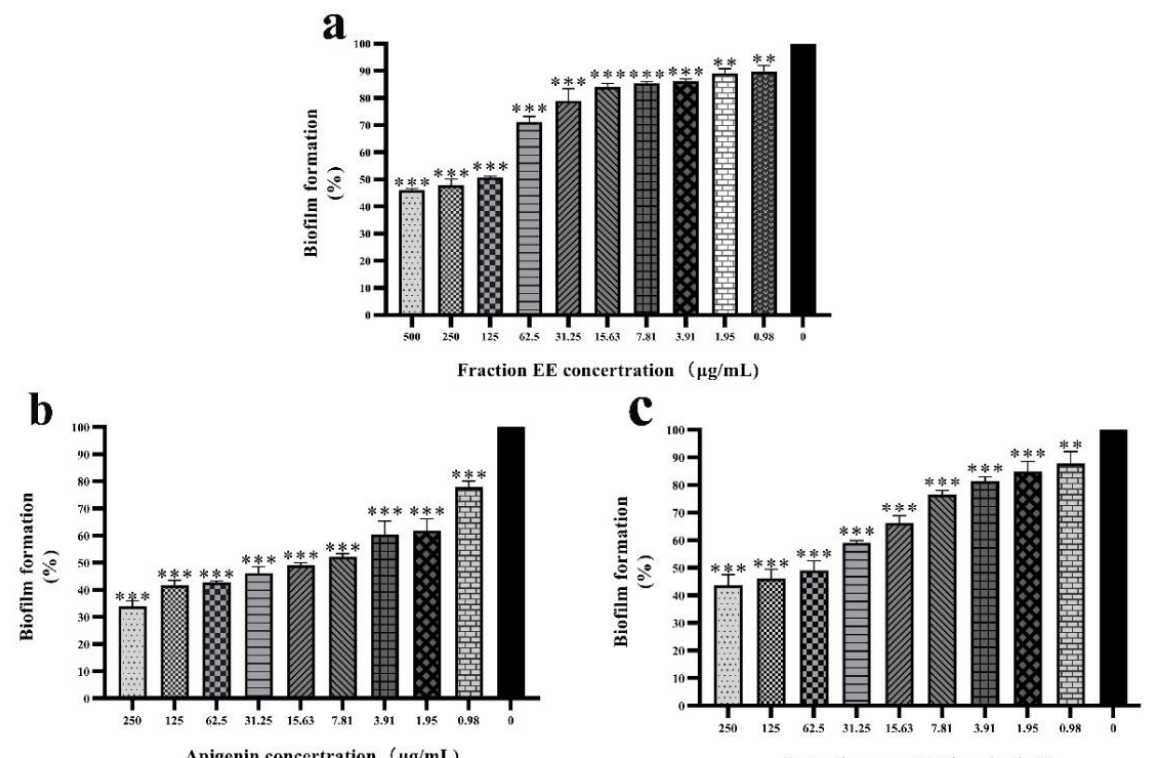
Figure 3. Inhibitory rate of apigenin, luteolin, and EE fraction on C. violaceum biofilm formation. ( a ) Biofilm formation of C. violaceum was quantified at OD 490 in the presence of EE fraction at 0 – 500 µg/mL 30 °C after 24 h in 96-well plates. ( b ) Biofilm formation of C. violaceum was quantified at OD 490 in presence of apigenin at 0~250 µg/mL 30 °C after 24 h in 96-well plates. ( c ) Biofilm formation of C. violaceum was quantified at OD 490 in presence of luteolin at 0 – 250 µg/mL 30 °C after 24 h in 96- well plates. Columns represent means ± standard deviations. Statistically significant differences (de- termined by Student ’ s t-test) are indicated as *** p < 0.001, ** p < 0.01 vs. the control group.